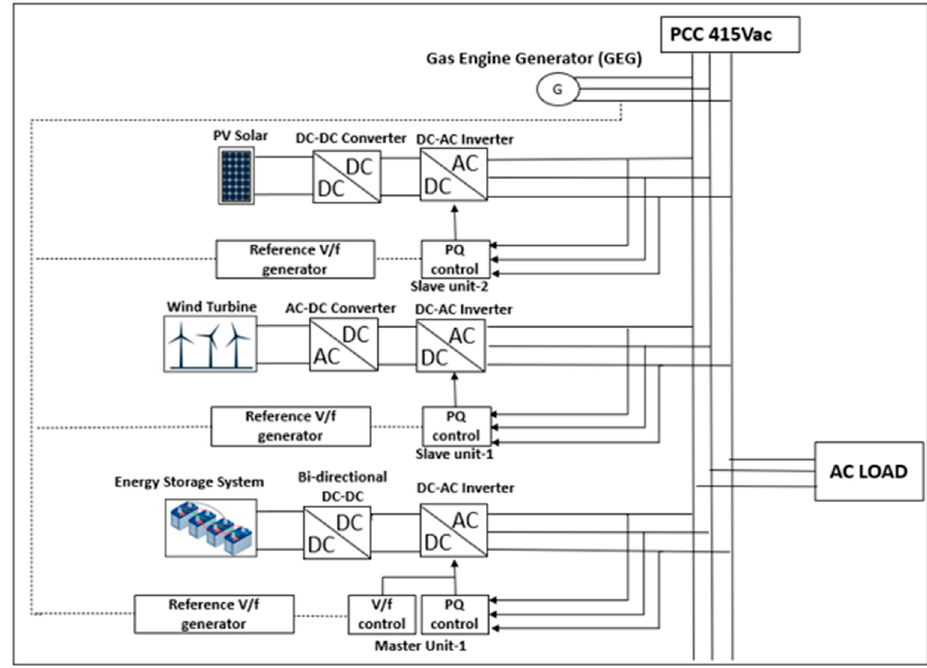
Figure 9. Sample architecture of master–slave control energy in microgrid.